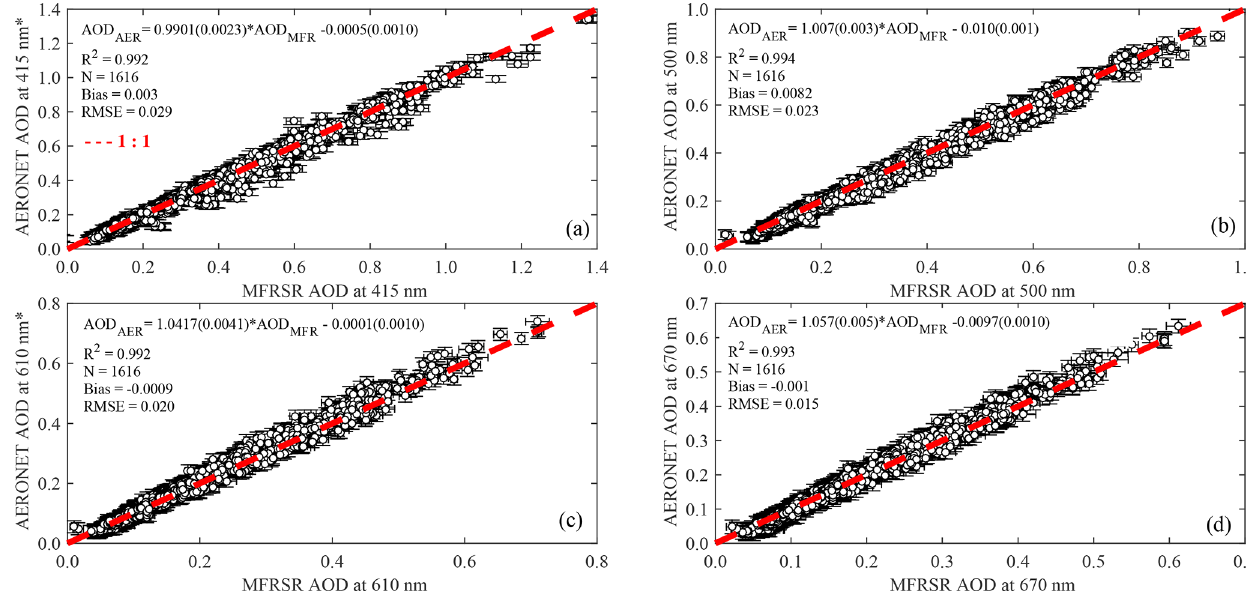
Figure 6. Spectral AOD retrieval from the on-site calibrated MFRSR as a function of AOD from the AERONET direct Sun product level 2.0 for 2015. The asterisk ( ∗ ) indicates that the AOD at that wavelength was estimated using the Ångström exponent and the red dashed line represents the 1 : 1 line.